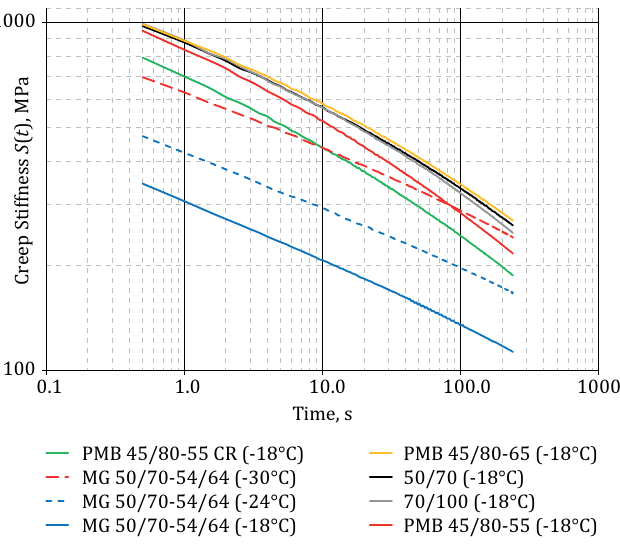
Figure 4. Curves of the creep stiffness modulus versus time for soft consistency